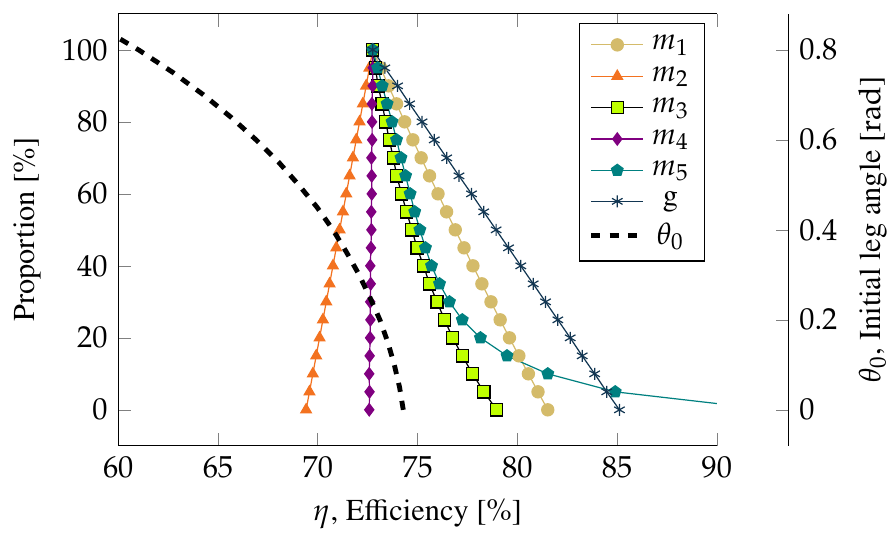
Figure 9. Undamped energy conversion efficiency sensitivity to laboratory demonstrator parameters. Proportions with respect to the values in Table 2.